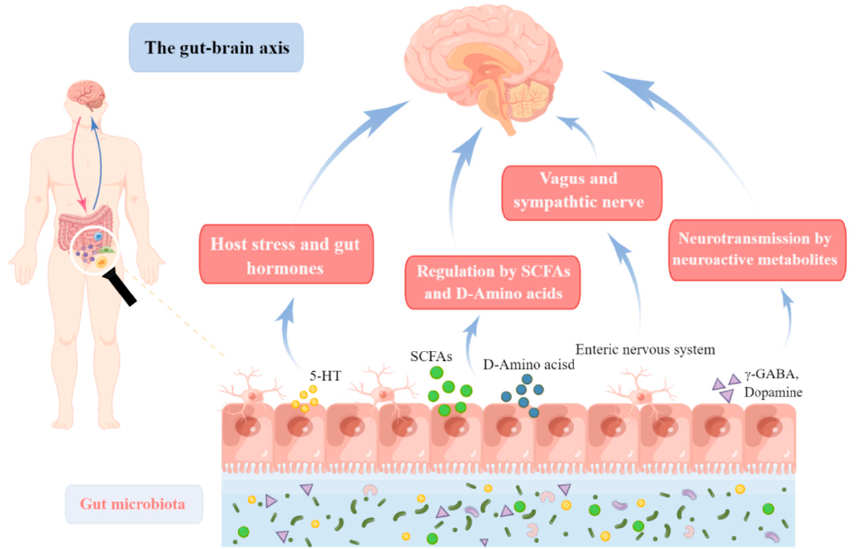
Figure 2. The role of the GBA in depression. Dysbiosis in the gut flora can be caused by an unhealthy lifestyle, excessive and continuing stress, disease, or other factors. The GBA’s bidirectional control of aberrant physiological states via neural, immunological, or chemical signals may result in depression.